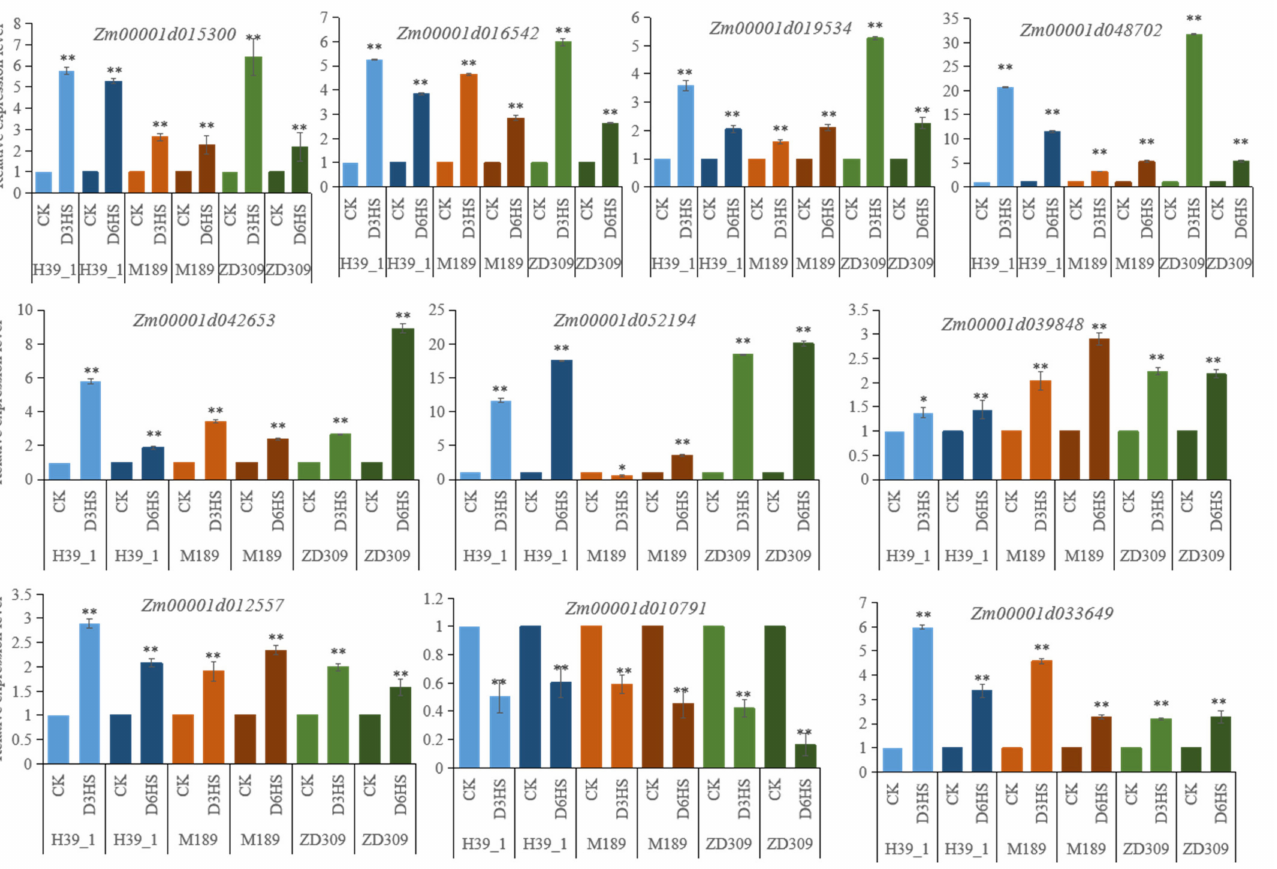
Figure 5. Verification the expression of DEGs by qRT-PCR. Bars show standard error of the relative expression levels. * and ** represent that the corresponding gene expression level in heat-stressed maize plants are significantly and very significantly different from the control at p < 0.05 and p < 0.01 levels,